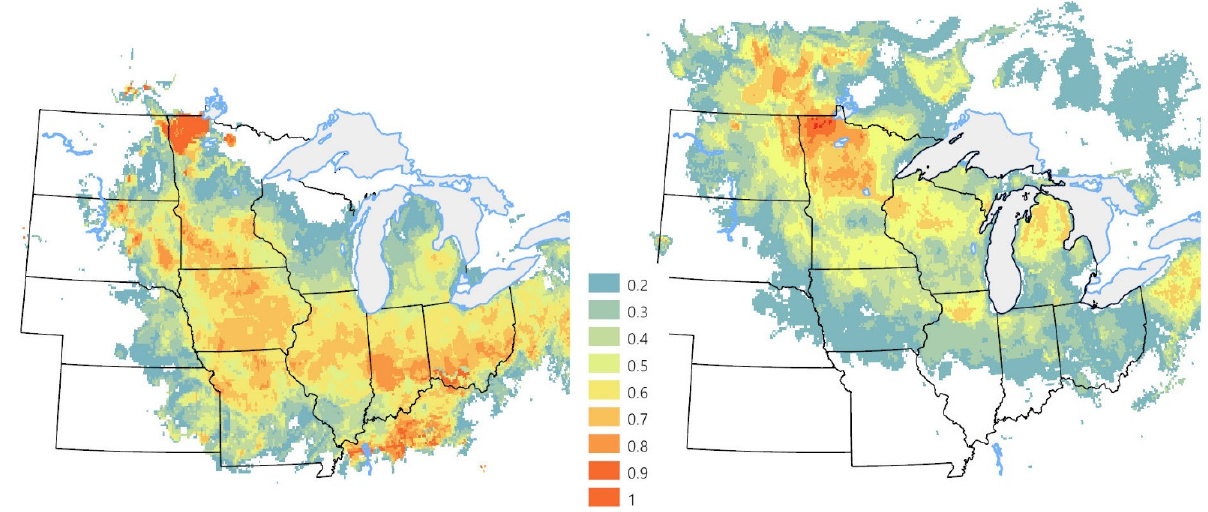
Figure 2. Climate suitability model for recent (2050–2000) conditions, left, and 2050, right. Suitability values, shown in center scale, range from 0 (unsuitable) to 1 (highly suitable).